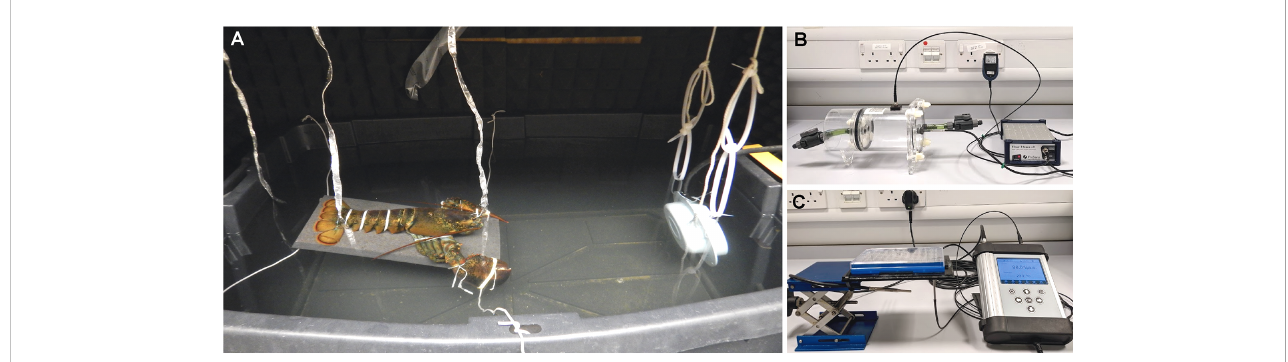
FIGURE 2 (A) Electrophysiology. (B, C) : Respirometry. (A) : Evoked potential hearing test of an American lobster ( Homarus americanus ) (B) : Respiration set-up for adult invertebrates; calibrated volume sealed respiration chamber connected to a fi box 3 trace v3 fi bre-optic trace oxygen meter (Presens – Precision Sensing, Regensburg, Germany) via fi bre-optic cable to a PSt3 oxygen sensor spot (detection limit: 0.03% oxygen, 15ppb). (C) : Plate set-up used for larvae and gametes; 64 well plate with PSt7 oxygen sensor spots (detection limit: 0.03% oxygen, 15ppb) attached to a fi box 4 trace hand held oxygen meter (Presens – Precision Sensing, Regensburg, Germany). Both ( B, C use non-destructive oxygen measurements, measuring luminescence decay time by stimulating an immobilised luminophore with monochromic